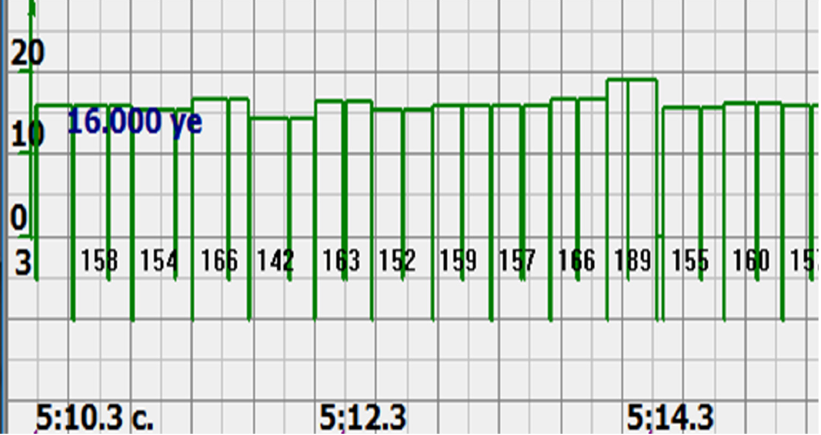
Figure 10. Heart rate intervals are divided by vertical lines into positive and negative half-waves in proportion to the duration of these half-waves.